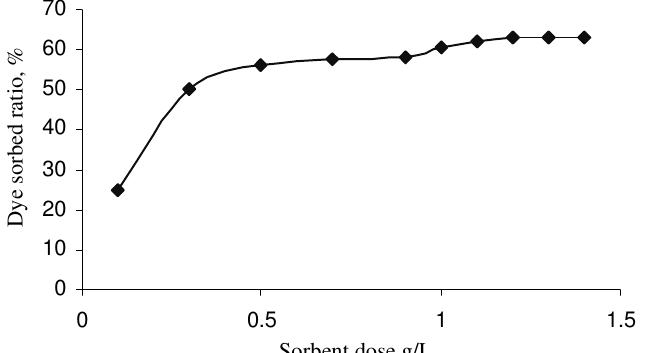
Figure 1 . Effect of sorbent dose on adsorption of Grey BL by mango leaves powder (MLP) (dye concentration: 100 mg/L; particle size: 400 µ contact time: 5 h; pH